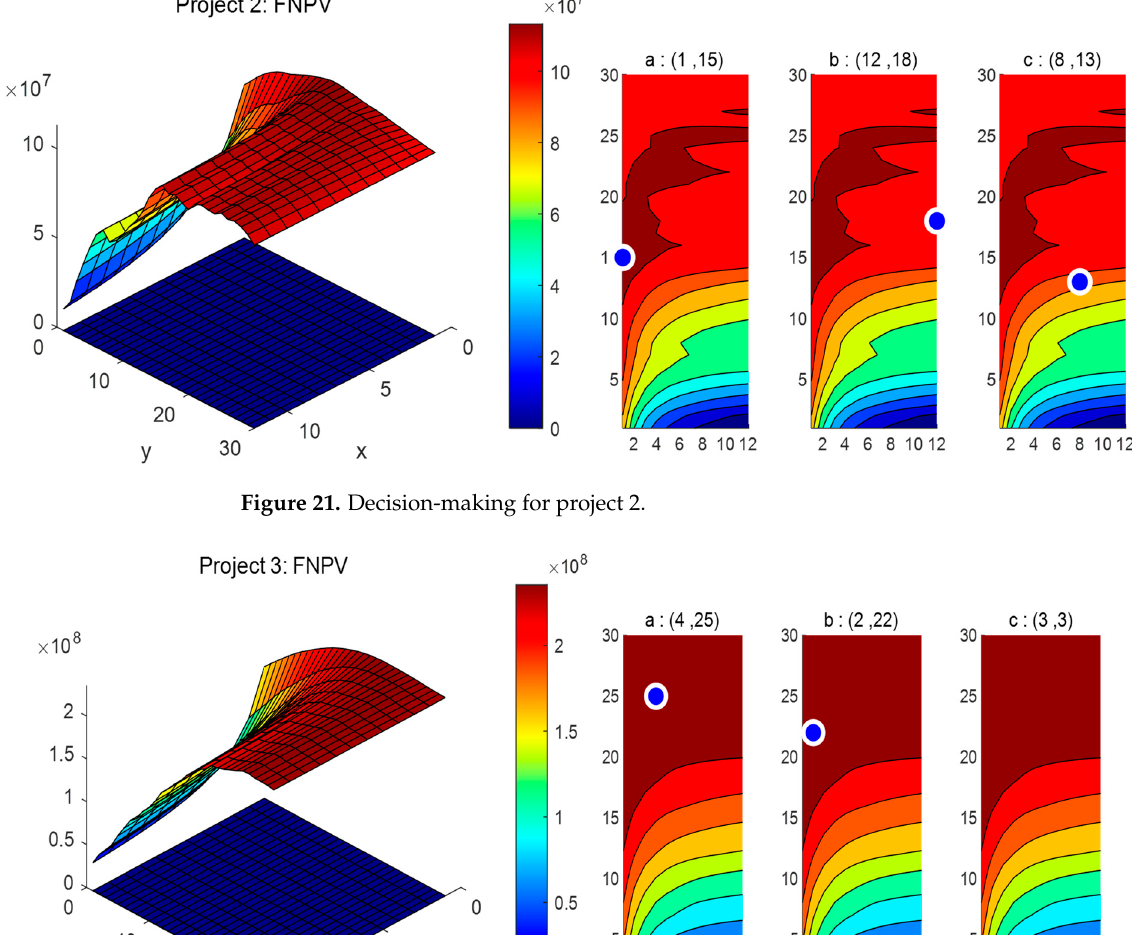
Figure 21. Decision − making for project 2.